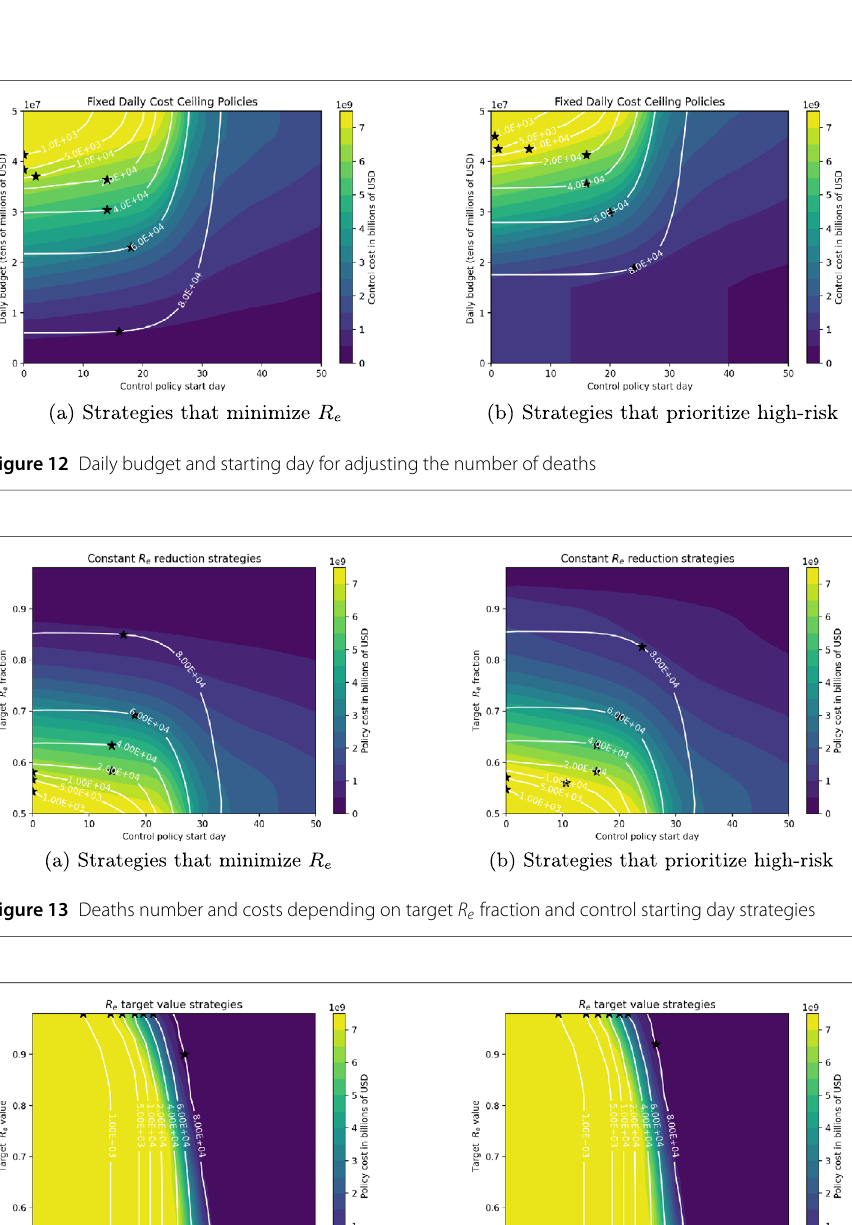
would be applied to the high-risk population, and additional controls would also be placed on the low-risk population so that R e = 0.9 can be achieved. Figures 12–14 show the cost and timing characteristics of the two variants of the three types of strategies considered. Each plot shows the costs (color level) and deaths (white contour lines) for each combination of policy start day ( x axis) and policy severity level ( y axis). For each figure, Subfigure (a) shows the regular case where controls are chosen to reduce R e at the lowest cost; while Subfigure (b) shows the results of policies that first prioritize controls on high-risk